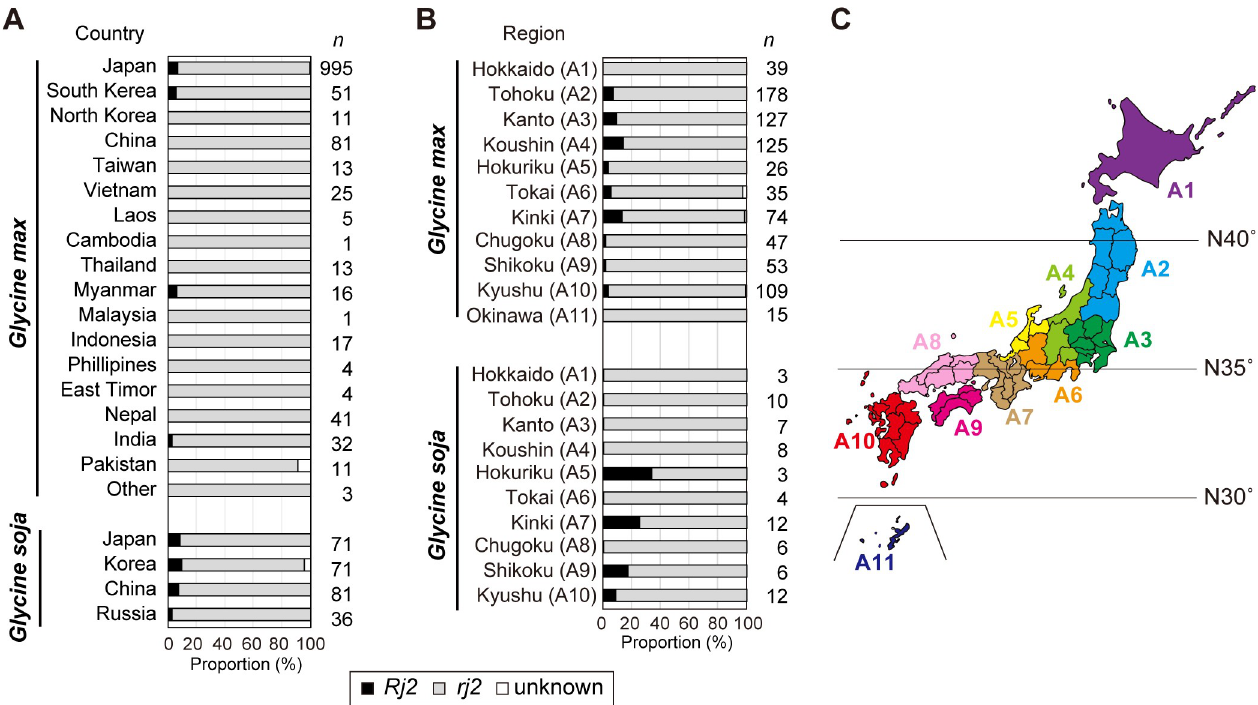
Fig 4. Geographical distribution of Rj2 -genotype soybean germplasm. (A) Proportion of Rj2 or rj2 genotypes in soybean germplasm by country of origin. (B) Proportion of Rj2 or rj2 genotypes in Japanese soybean landraces by region of origin. Black and gray bars: percentage of accessions featuring Rj2 and rj2 genotypes, respectively. White bars: percentage of accessions that could not be determined by this analysis. n : numbers of tested soybean accession. (C) Map of Japan. Japan was subdivided into 11 regions (A1-A11) with reference to Kaga et al. [7]. The colors are arbitrary.